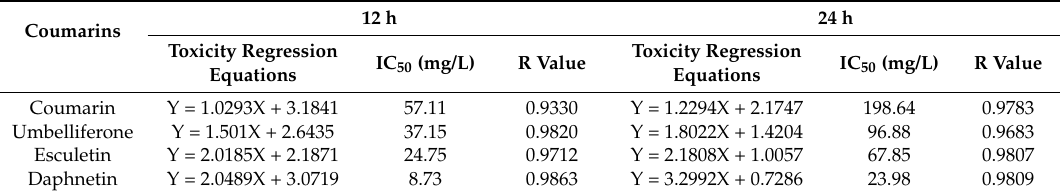
Figure 2. The effect of coumarins at concentrations ranging from 10 to 100 mg/L on the growth curves of R. solanacearum : ( a ) coumarin; ( b ) umbelliferone; ( c ) esculetin; ( d ) daphnetin. Table 3. The IC 50 s of coumarins against R. solanacearum.